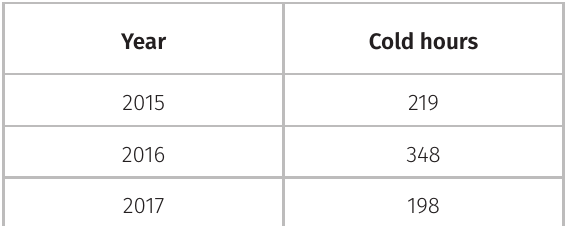
Table II. Data on cold hours (below 7.2°C) from 2015 to 2016, at the Estação Experimental Cascata (EEC) Pelotas, RS, Brazil.